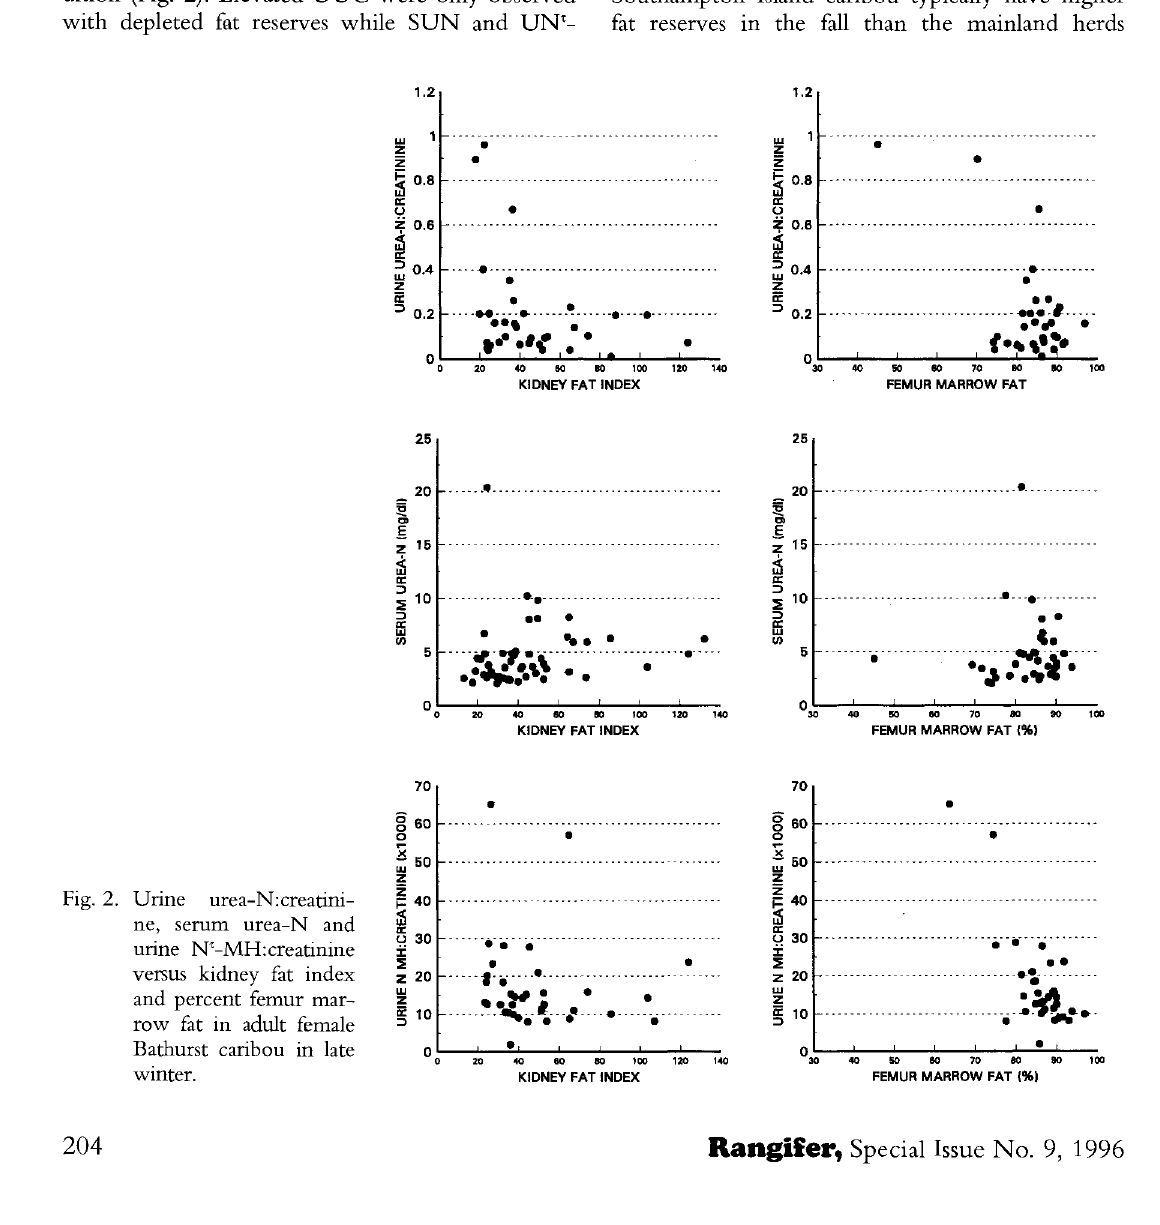
Fig. 2. Urine urea-N: creatini ne, serum urea-N and urine N'-MH:creatinine versus kidney fat index and percent femur mar row fat in adult female Bathurst caribou in late